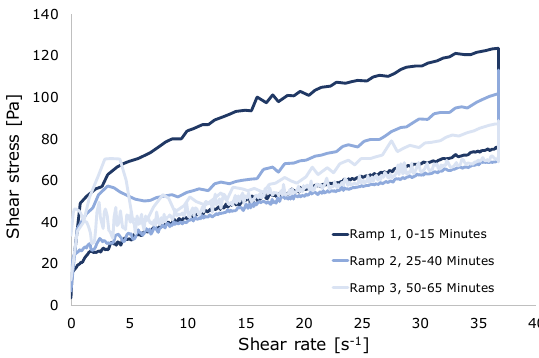
Figure 5. Hysteresis loops of cement paste in the presence of plasticiser and the gum of triumfetta pendrata A.